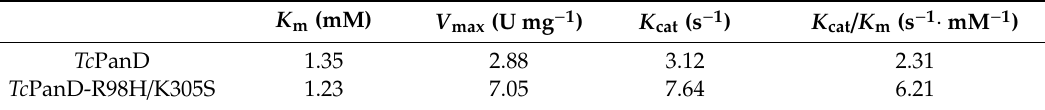
Table 2. Kinetic parameters of Tc PanD and Tc PanD-R98H /